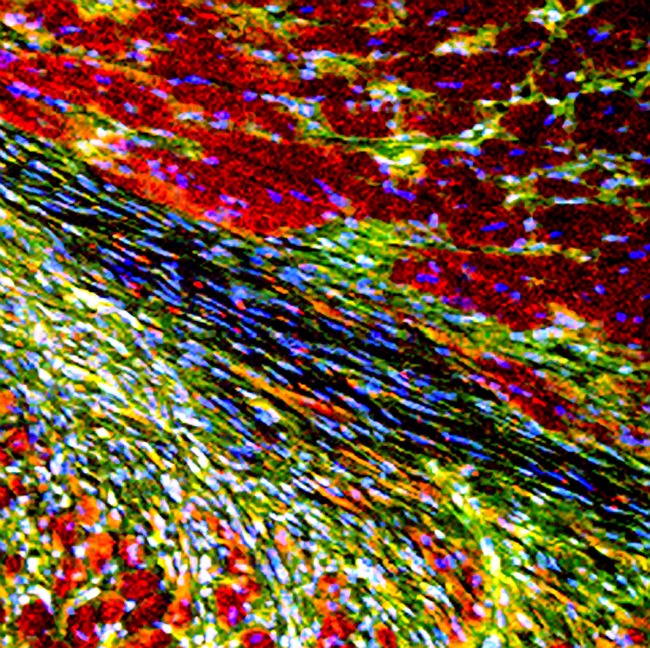
Spoc cells can help repair a damaged heart